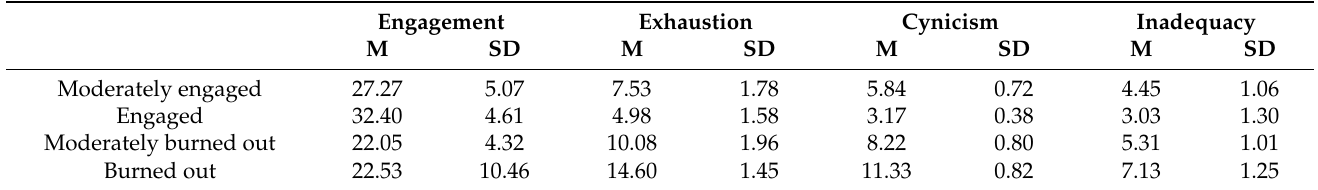
Table 3. Unstandardized final latent profile solution.